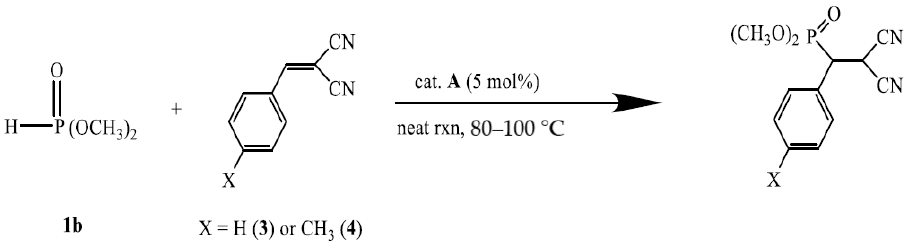
Table 4. Recycling results of A -catalyzed phospha-Michael addition of dimethyl phosphite ( 1b ) with 2-benzylidenemalononitrile ( 3